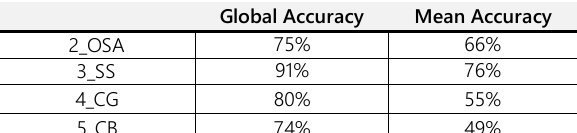
Table 2: DeepLabv3+ results on the test set (Test 1).